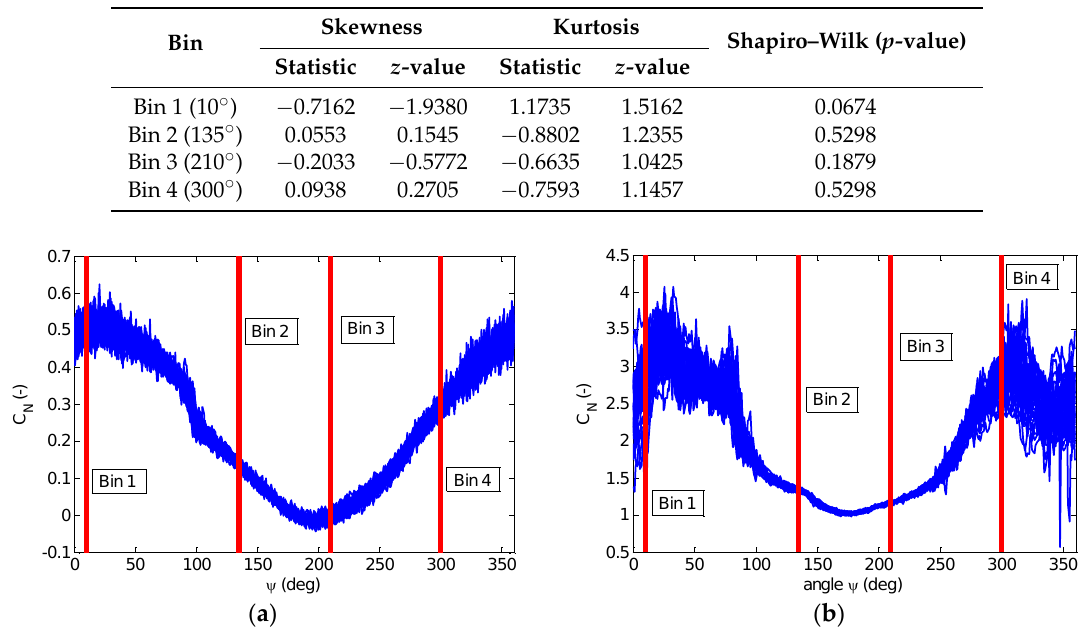
Figure 11. ( a ) U ∞ = 5 m/s, Φ = 30°, and r / R = 0.30; ( b ) U ∞ = 15 m/s, Φ = 30°, and r / R = 0.80. Figure 11. ( a ) U Φ = 30 ˝ , and r / R = 0.30; ( b ) U 8 = 5 m/s,